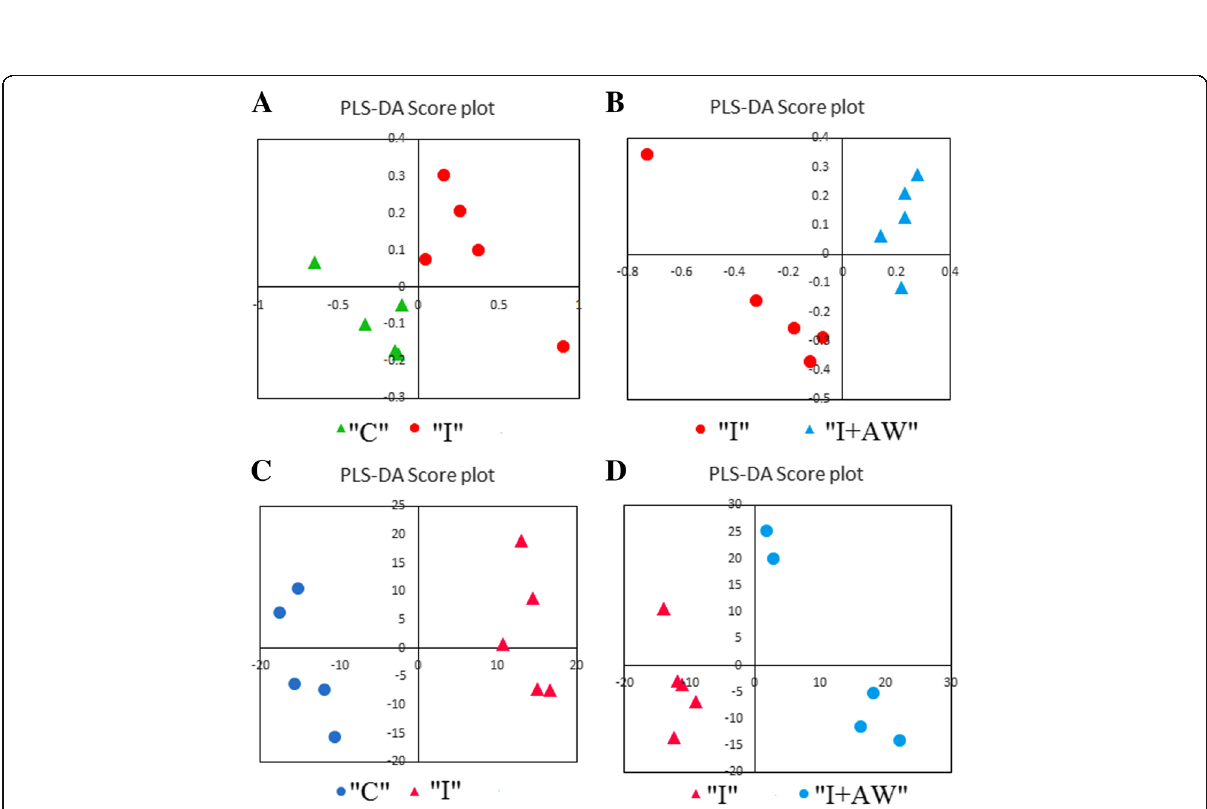
Fig. 8 The PLS-DA score plots of serum ( a , b ) and tissue ( c , d ) samples for the comparison of “ C-I ” and “ I-I+AW ” . The models could successfully discriminate the study groups. ( “ C ” : control group, “ I ” : rats with indomethacin-induced gastric ulcer, “ I+AW ” : ulcerated rats treated with AW